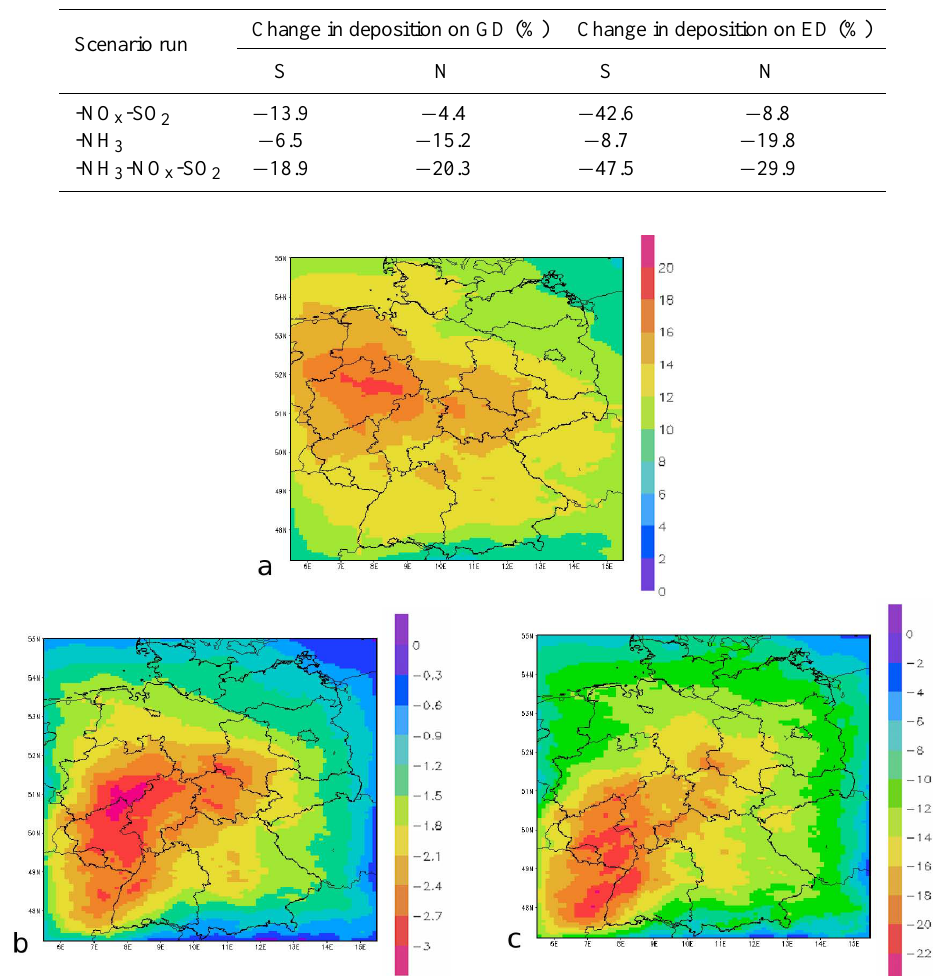
Fig. 11. (a) Base case mean SIA concentration (µgm − 3 ) of the investigation period and (b) absolute and (c) relative SIA reduction by means of the − 40%NH 3 GD scenario run compared to the base